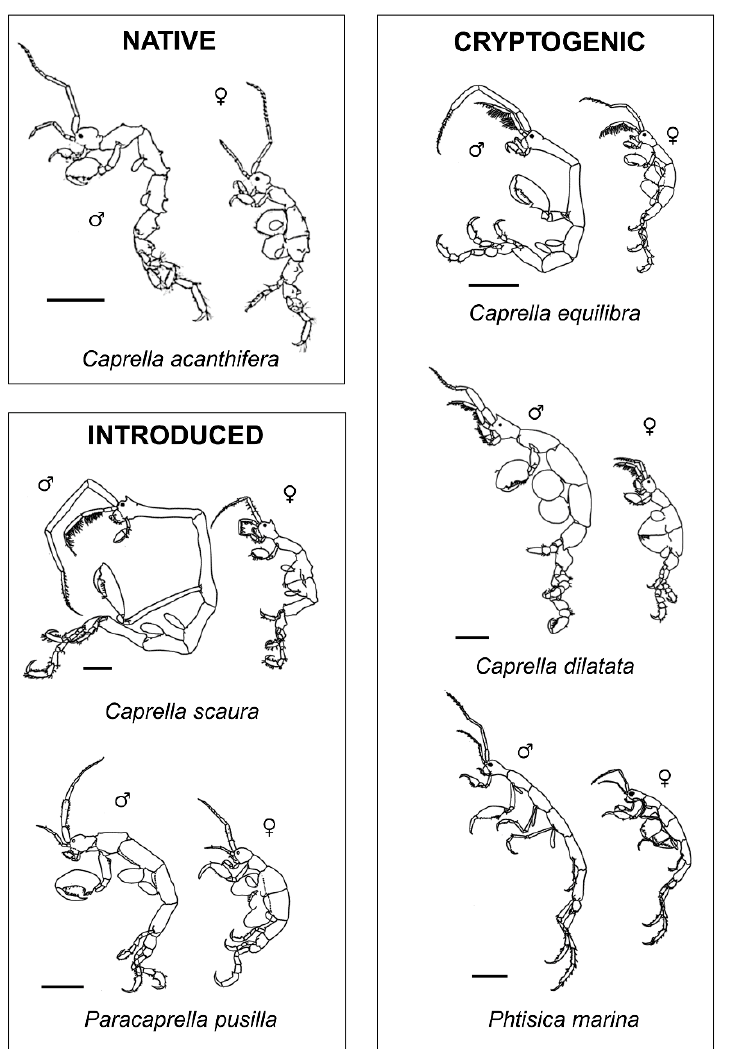
Figure 2. Lateral view figures of the caprellid species found during the present study. Scale bars: 1 mm.